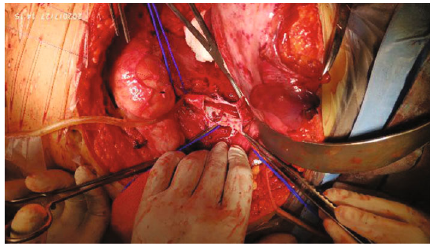
Figure 3: Cavotomy and removal of tumor thrombus.